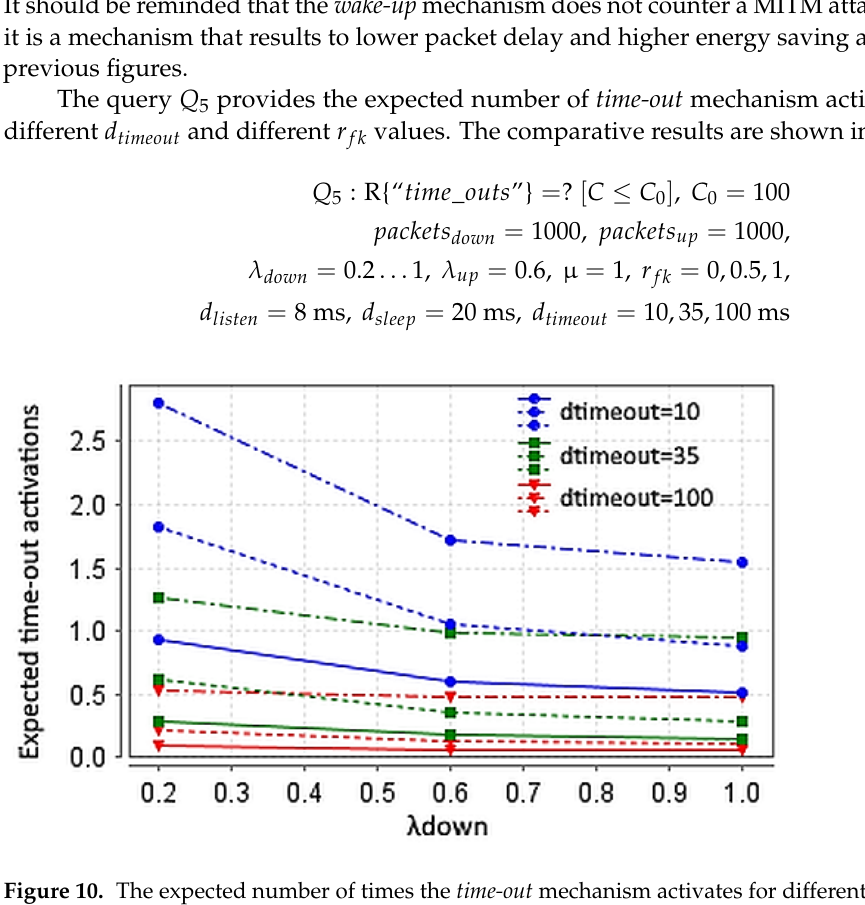
Figure 10. The expected number of times the time-out mechanism activates for different d timeout and different r fk values. r fk = 0 (solid line), r fk = 0.5 (dotted line), r fk = 1 (dashed